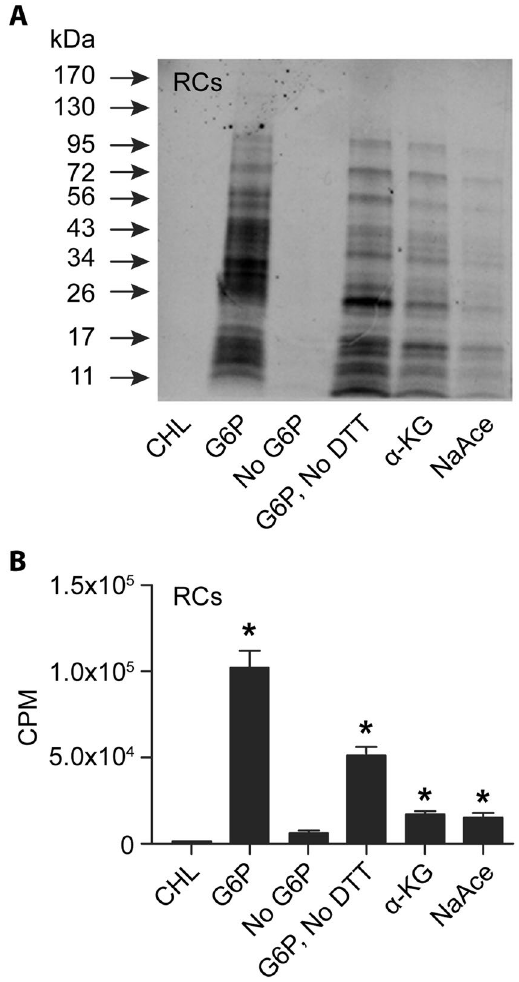
Figure 5. Axenic media assessment using different carbon sources for the RC fraction. ( A ) Autoradiography imaging was assessed with the axenic media containing G6P with DTT (G6P); without an energy source (no G6P); with G6P in the absence of DTT (G6P, No DTT); with α -keto glutaric acid ( α -KG) or sodium acetate (NaAce) as energy sources. The first lane included axenic media with G6P and CHL to serve as the negative control. ( B ) As in panel A, but scintillation counting data were presented. Significant change noted relative to CHL control in the experimental samples are identified with a * above each